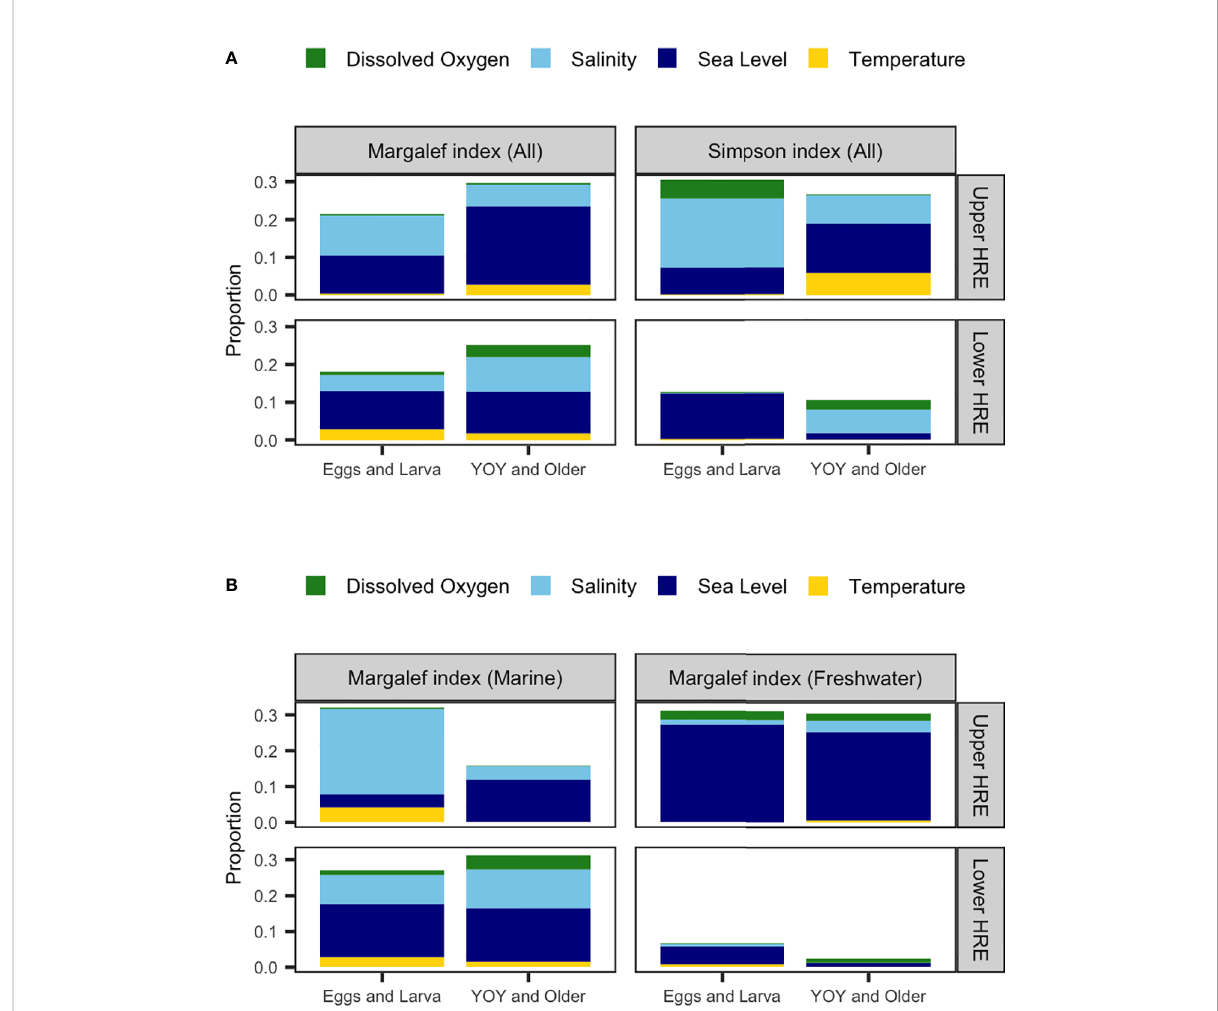
FIGURE 5 The relative importance of each variable (as indicated by color) in the models of (A) Margalef index ( d all ) and Simpson index ( D all ) for all species, and (B) Margalef index for marine ( d marine ) and freshwater ( d freshwater ) species for early (eggs and larva) and older (young-of-year [YOY] and older) life stages in the upper and lower Hudson River Estuary